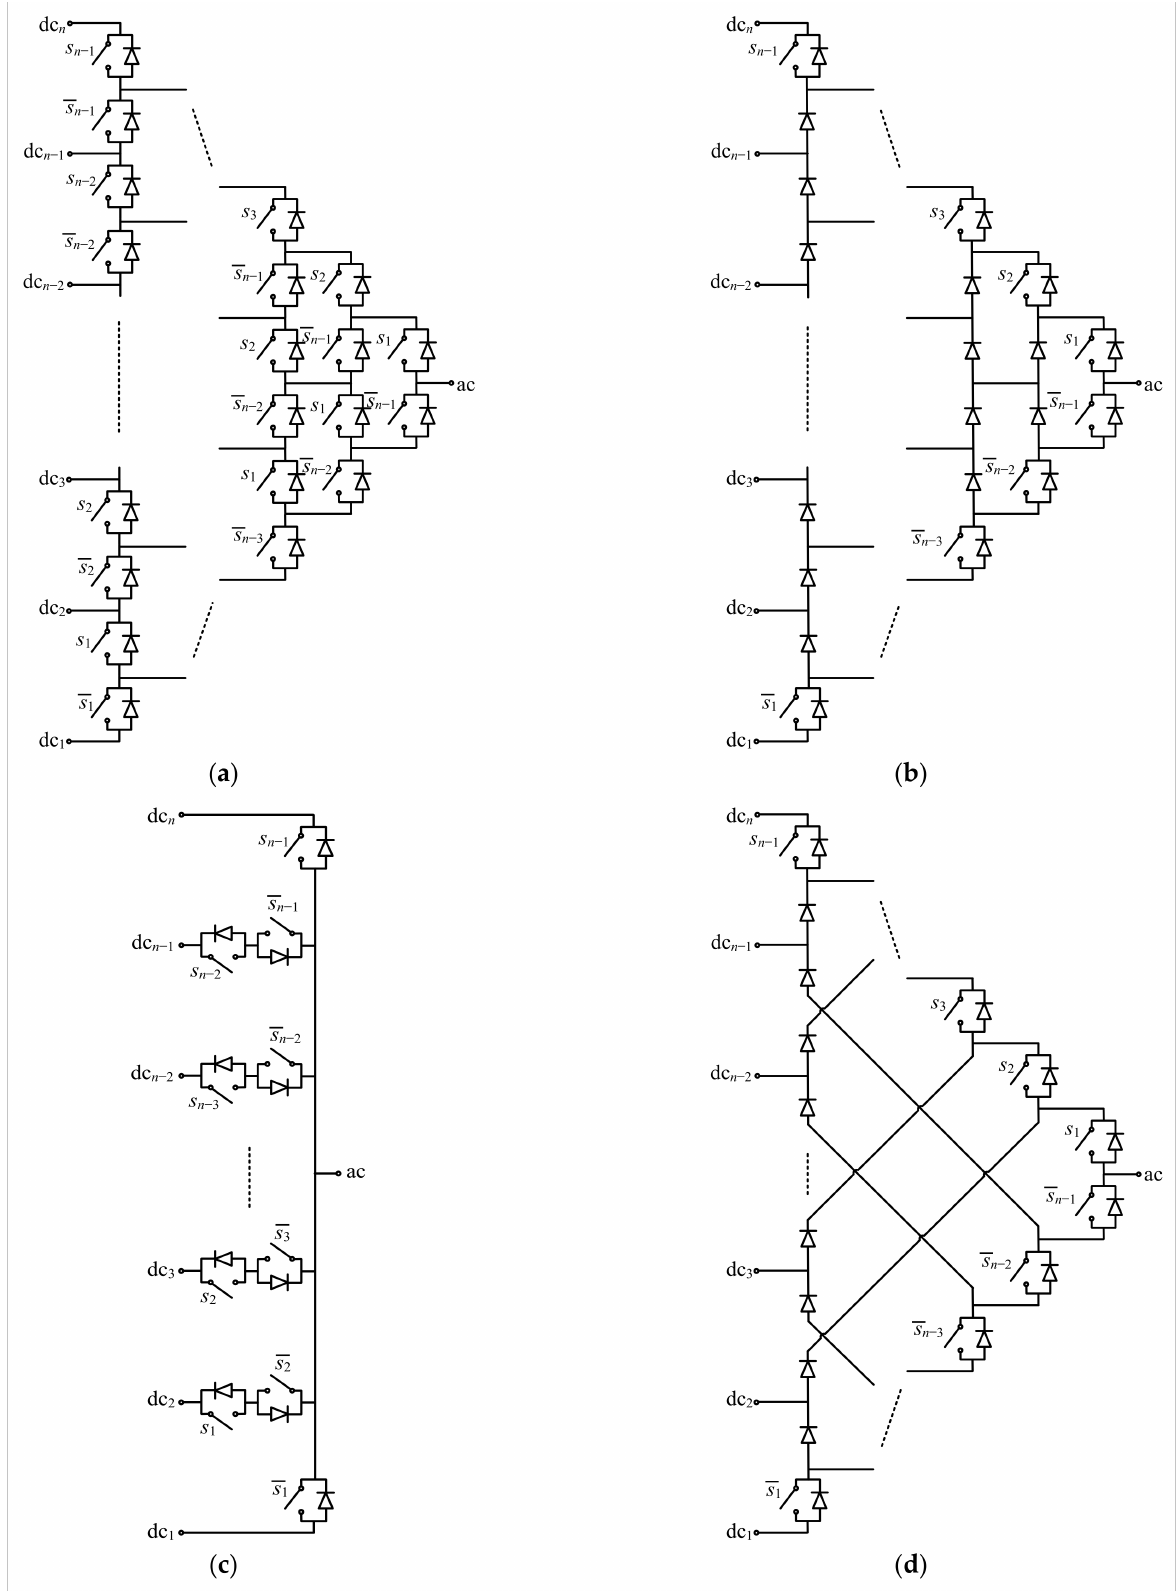
Figure 3. NPC leg topologies [9]. ( a ) Active NPC (ANPC); ( b ) passive NPC (PNPC); ( c ) reduced ANPC; ( d ) reduced